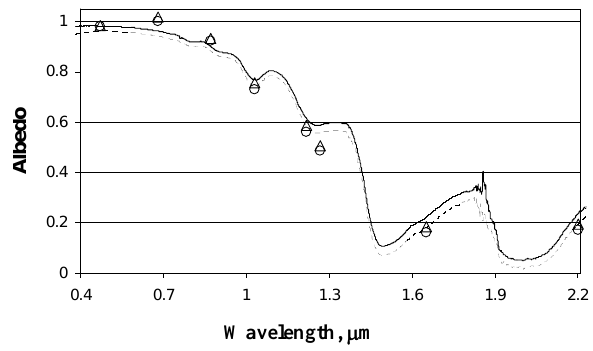
Figure 1. Spectral albedo measurements on Elson Lagoon on April 15, 2008, with the P-3B air- plane in the background. The leveled cosine collector is rotated to collect light from upward and